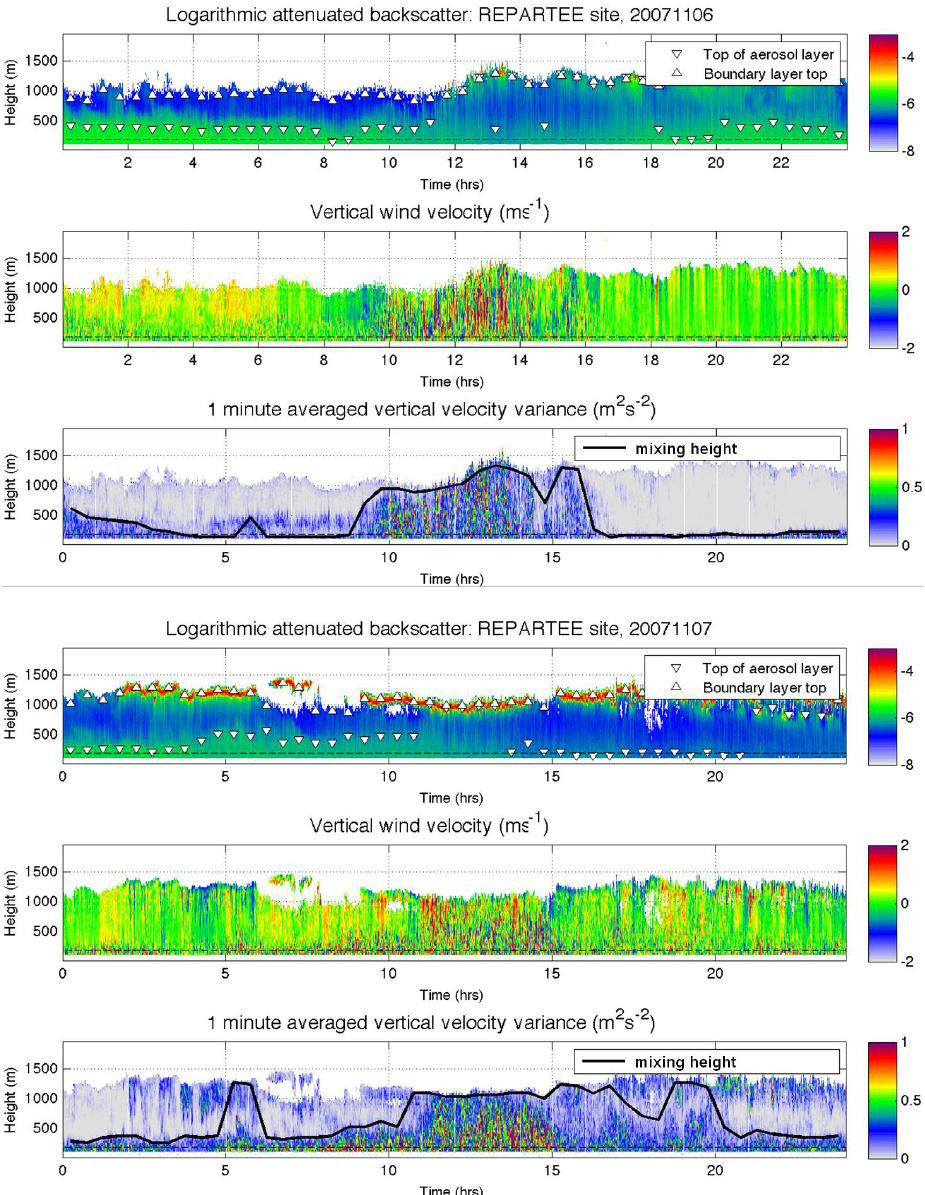
Figure 4. Doppler lidar observations of backscatter (m -1 sr -1 , log 10 scale), vertical wind Fig. 4. Doppler lidar observations of backscatter β (m − 1 sr − 1 , log 10 scale), vertical wind velocity w (ms − 1 ) and variance of vertical wind velocity σ 2 w (m 2 s − 2 ) . Observations show 1min averages of 0.278Hz data. Derived heights of boundary layer top, aerosol layer and mixing velocity w (m s -1 ) and variance of vertical wind velocity w2 (m 2 s -2 ). Observations show 1 height are also shown. Height of BT Tower (190m) is depicted as dashed line. (a) 6 November 2007, (b) 7 November minute averages of 0.278 Hz data. Derived heights of boundary layer top, aerosol layer and mixing height are also shown. Height of BT Tower (190 m) is depicted as dashed line. b) 7